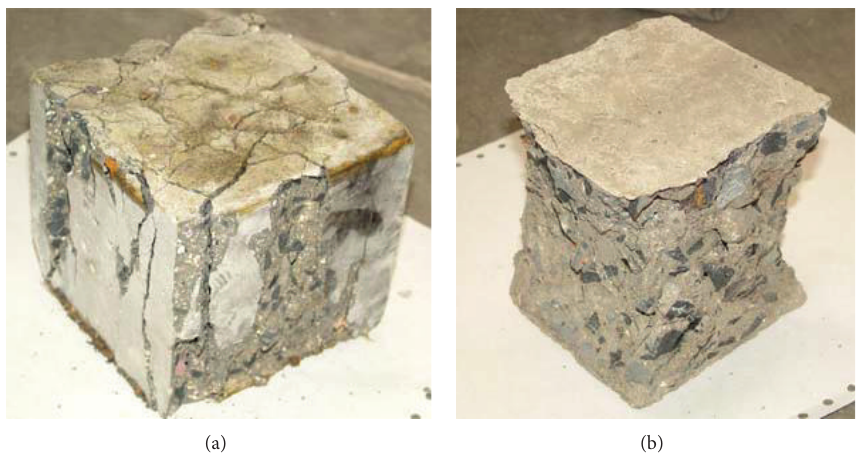
Figure 3: Failure modes of HPC under uniaxial compression.